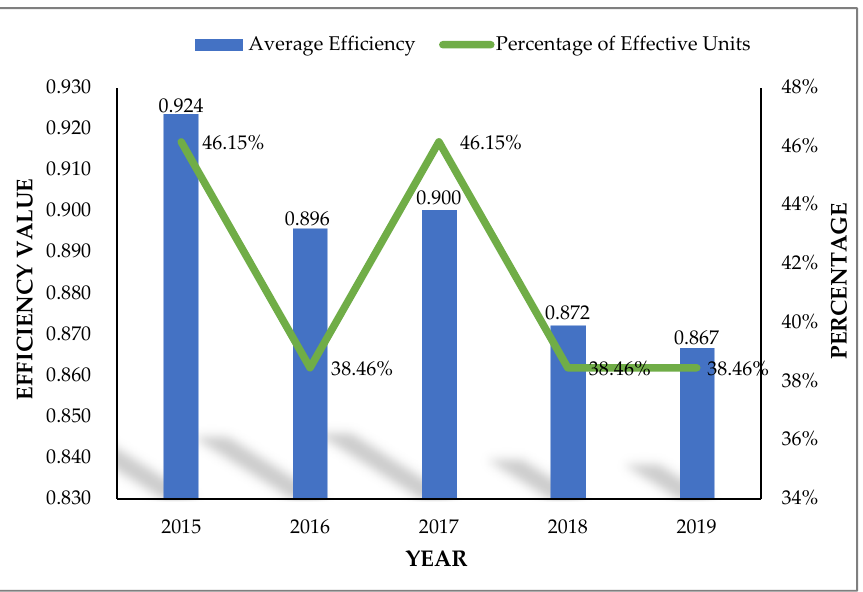
Figure 2. The average efficiency and the percentage of effective units in 13 cities in Jiangsu Province from 2015 to 2019.